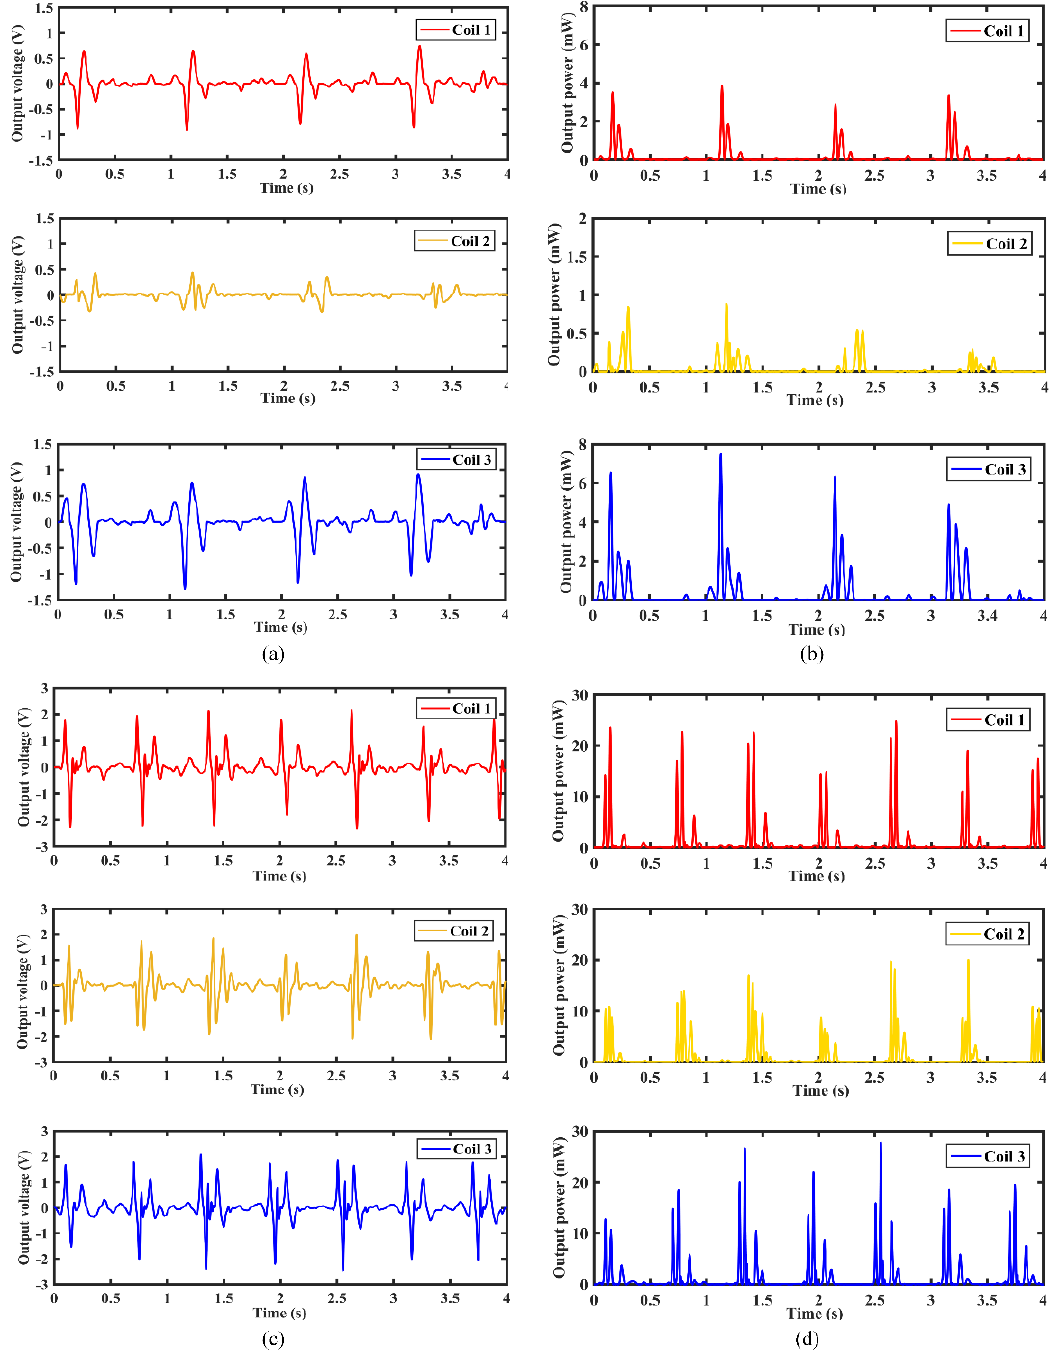
Figure 15. Output of the MCEEH installed vertical to the leg: ( a ) output voltage for moving speed at 3 km/h; ( b ) instanta- neous power output for moving speed at 3 km/h; ( c ) output voltage for moving speed at 6 km/h; ( d ) instantaneous power output for moving speed at 6 km/h.